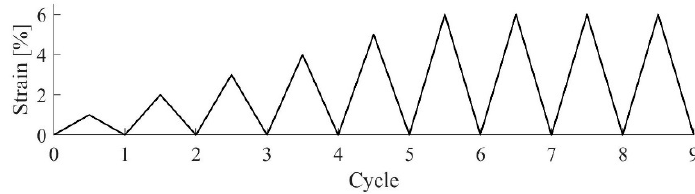
Figure 5. Loading protocol 2 applied at frequencies 0.02, 0.04, 0.2, 1.0 Hz used for S 21 , S 22 , D 21 , D 22 .